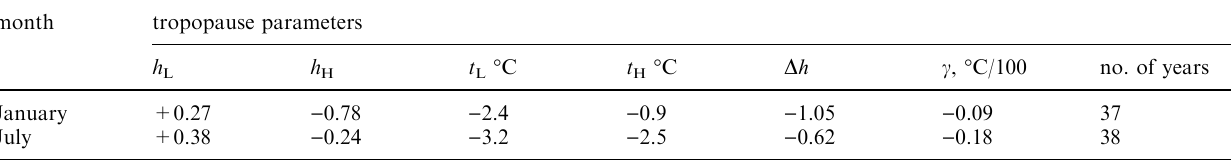
Table 3. Estimates of tropopause parameters (by linear trend) in the Arctic atmosphere 1954–1991. Note that h and upper boundaries of tropopause (km),